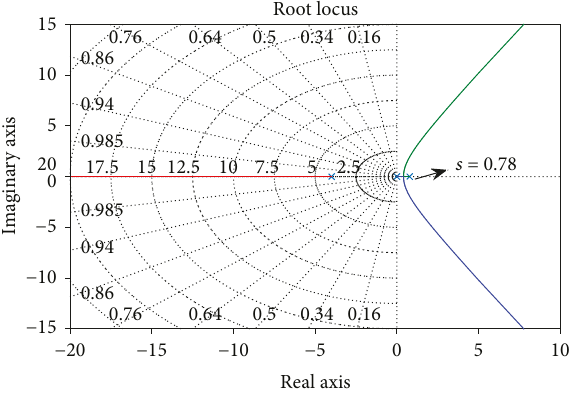
Figure 3: Root locus of zero-pole for the unstable system.